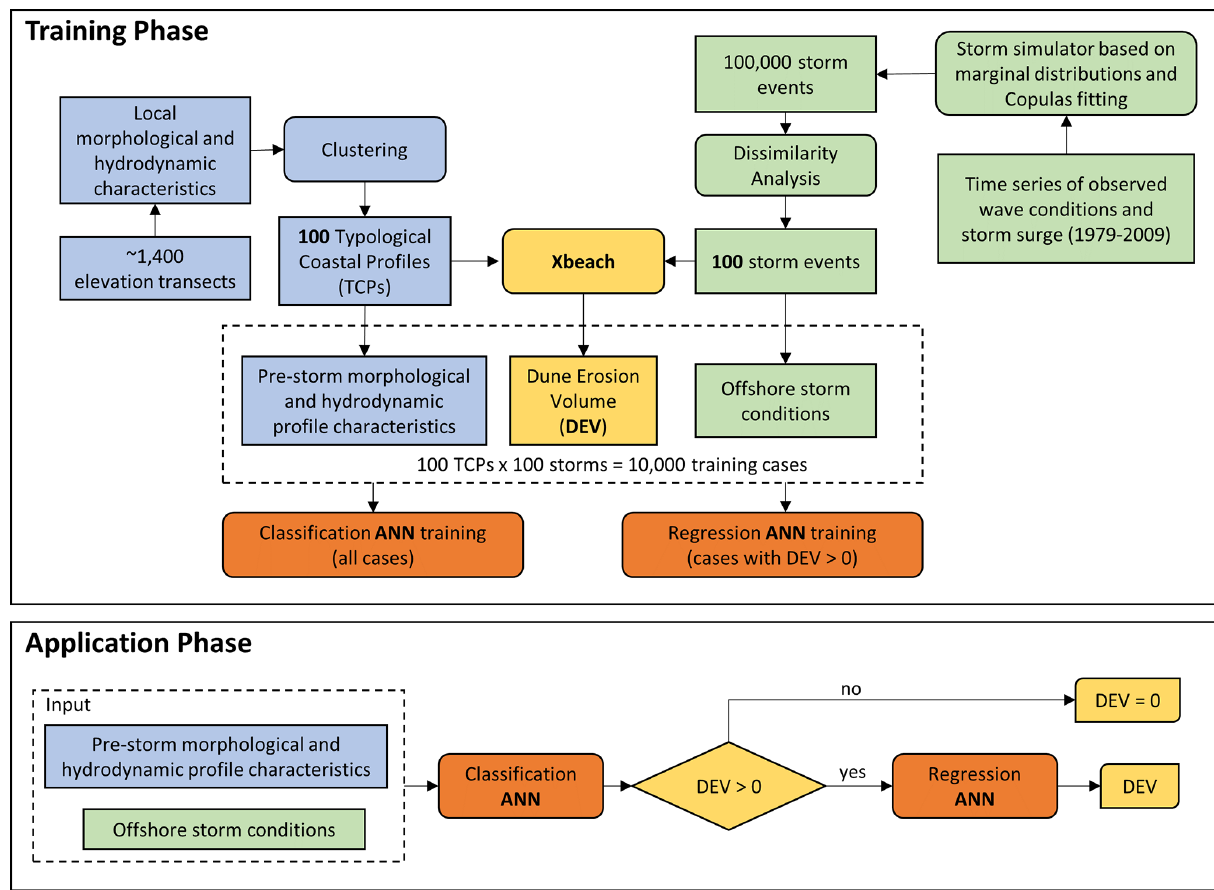
Figure 1. Overview of the training and application of the proposed meta-model for dune erosion volume (DEV) predictions. Blue colors indicate the steps associated with the profile characteristics, green colors the steps related to the offshore storm conditions, yellow colors the steps connected with dune response and orange colors the steps connected with artificial neural